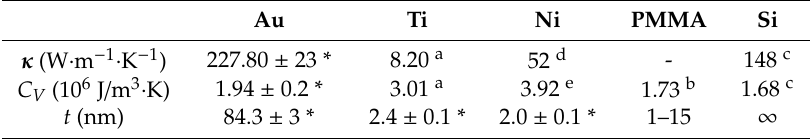
Table 1. Thermal conductivity κ and volumetric thermal capacity CV values for the Au film were found by measuring reference samples with Au directly deposited on quartz using a two-parameter fit. We measured metal film thicknesses by atomic force microscopy (AFM) on the reference samples. We measured polymethyl methacrylate (PMMA) thicknesses by ellipsometry on Si reference samples with < 10% error. The effective thermal conductivity κ of the PMMA layer is the unknown parameter, and hence is not listed in the table. Au Ti Ni PMMA Si